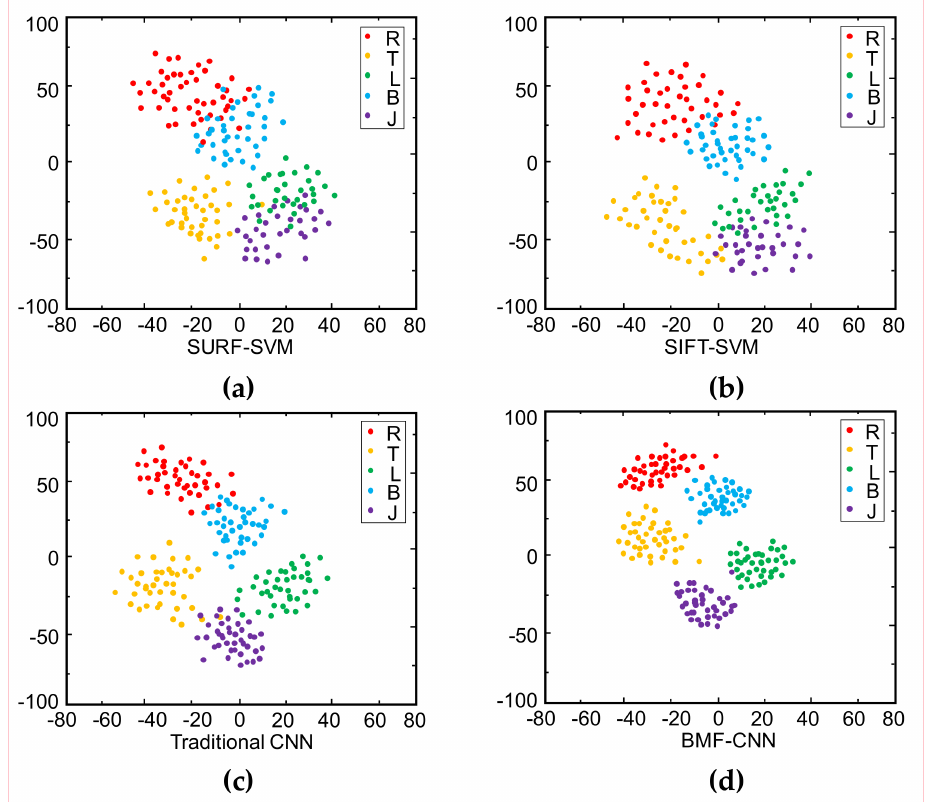
Figure 8. 2D feature visualization using t-distributed random neighbor embedding